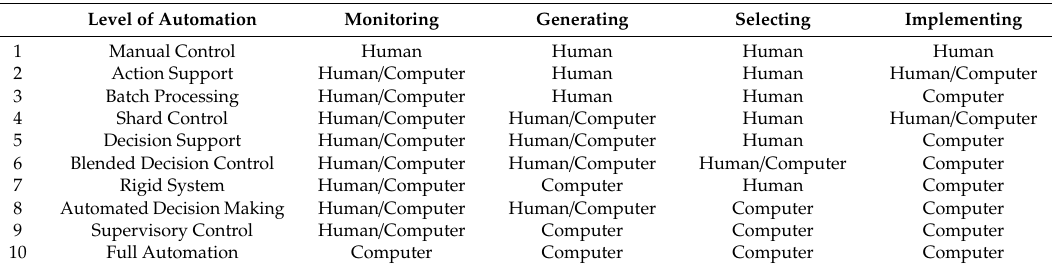
Table 1. Levels of automation [6].